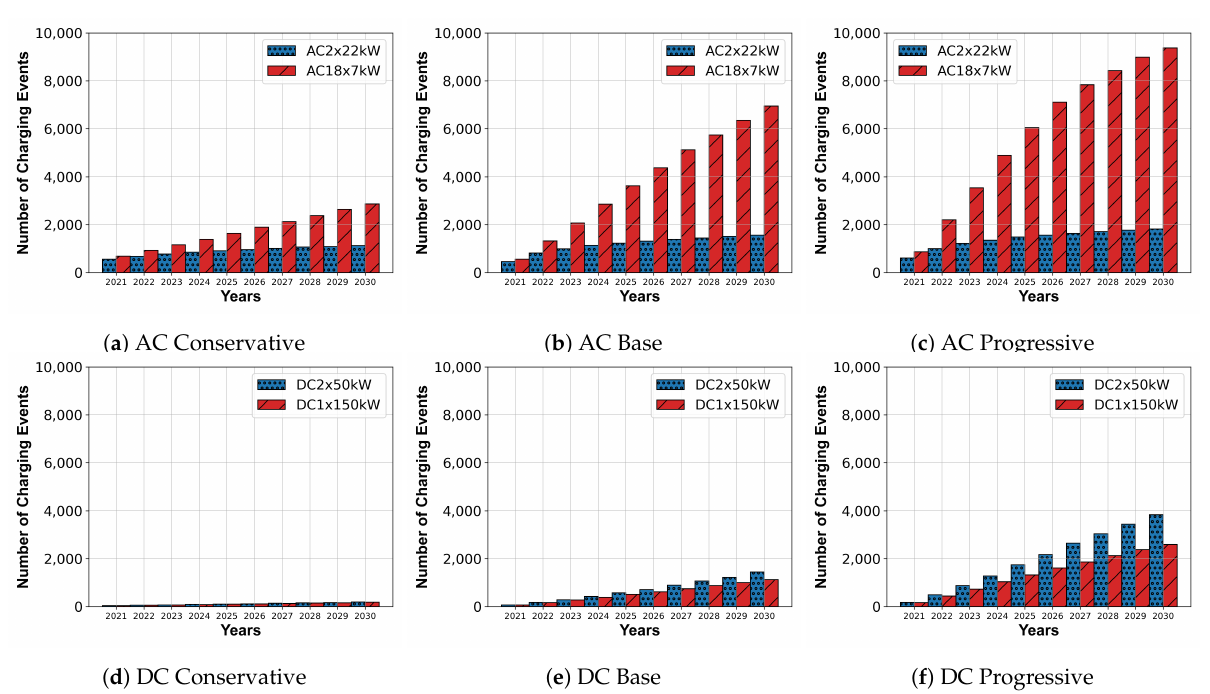
Figure A2. Number of Charging Events per Charging